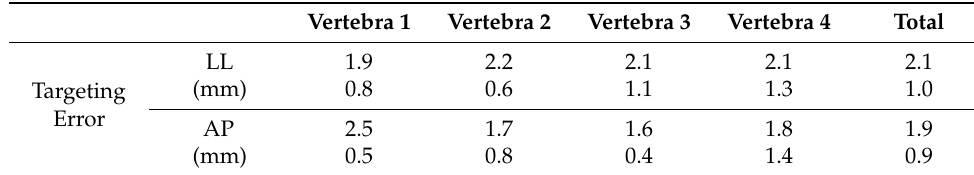
Table 2. Mean ( μ ) and standard deviation ( σ ) of the targeting error latero–lateral (LL) and antero ‐ posterior (AP) projections.